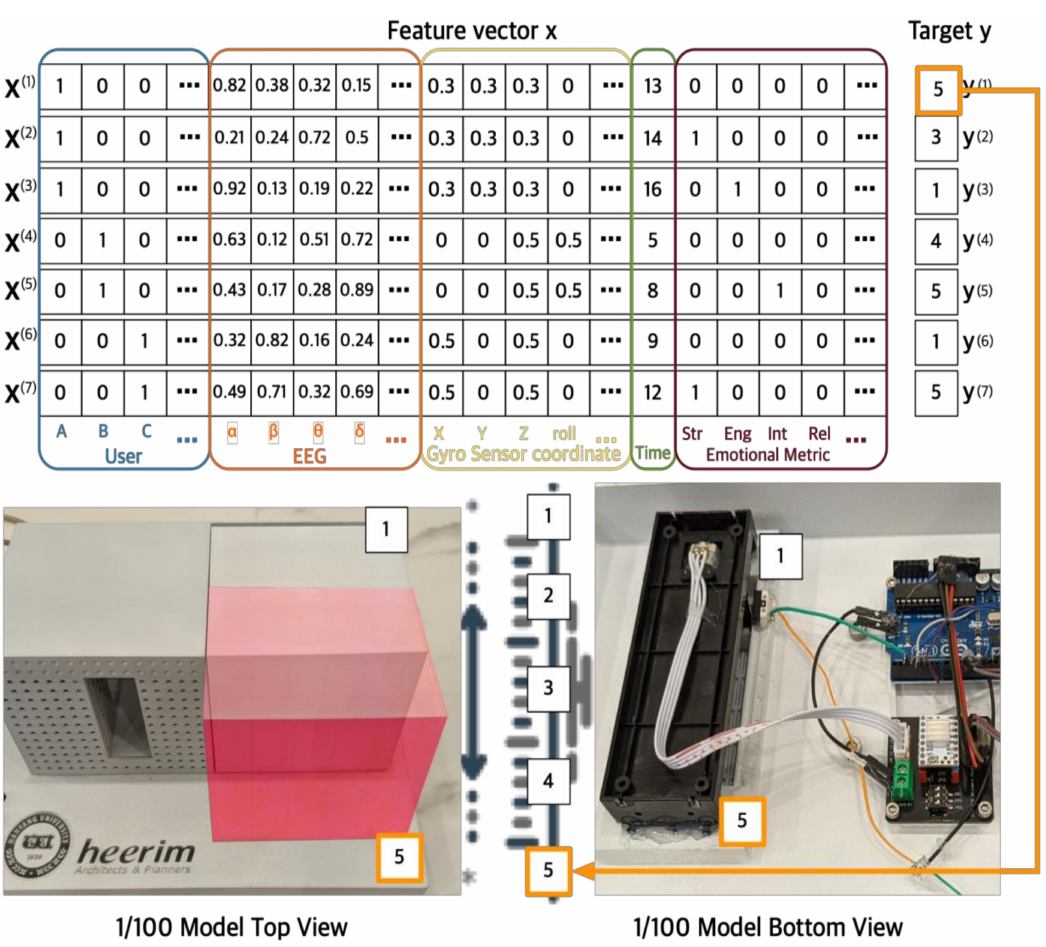
Figure 9. Smart space operation with application of DeepFM algorithm